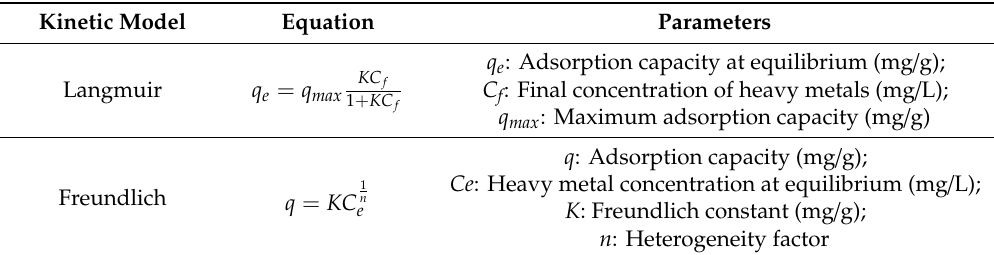
Table 2. Mathematical expressions of isotherm models.